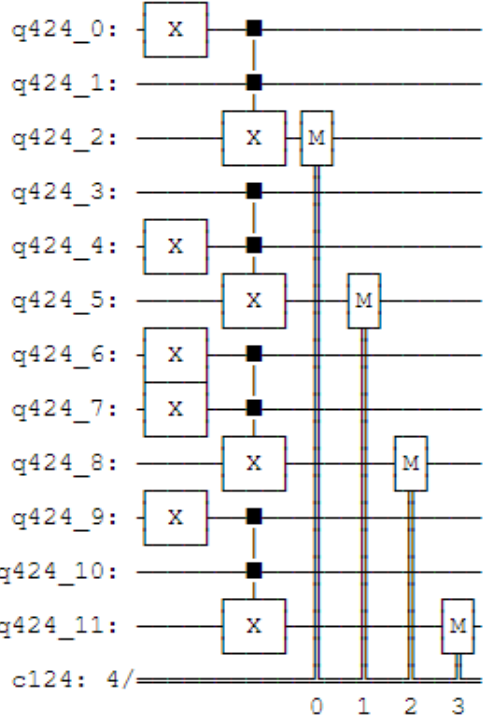
Figure 14. Classical AND gate using the Toffoli